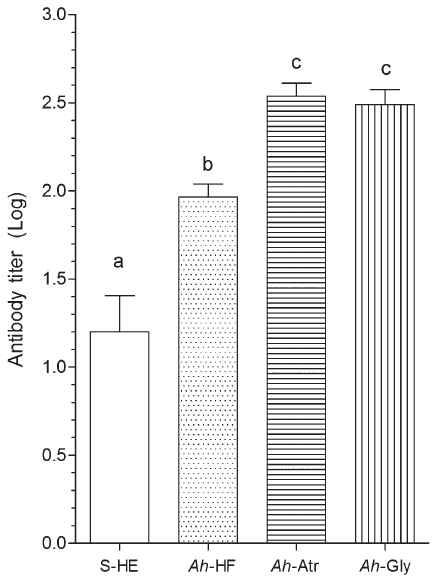
Figure 2. Exposure to atrazine or glyphosate increases the production of antibodies in silver catfish. Fingerlings were inoculated with inactivated Aeromonas hydrophila and kept on herbicide-free water ( Ah -HF), exposed to atrazine or glyphosate ( Ah -Atr and Ah -Gly, respectively) or inoculated with saline and exposed to herbicides (S-HE). Data from the S-HE represents all data from saline-inoculated fish exposed to either atrazine or glyphosate. Data are reported as means±SE. The results are shown as the logarithm of the last serum dilution that caused bacterium agglutination. One-way ANOVA and the Bonferroni post-test were used to compare the data and significant differences (P , 0.05) are indicated by different